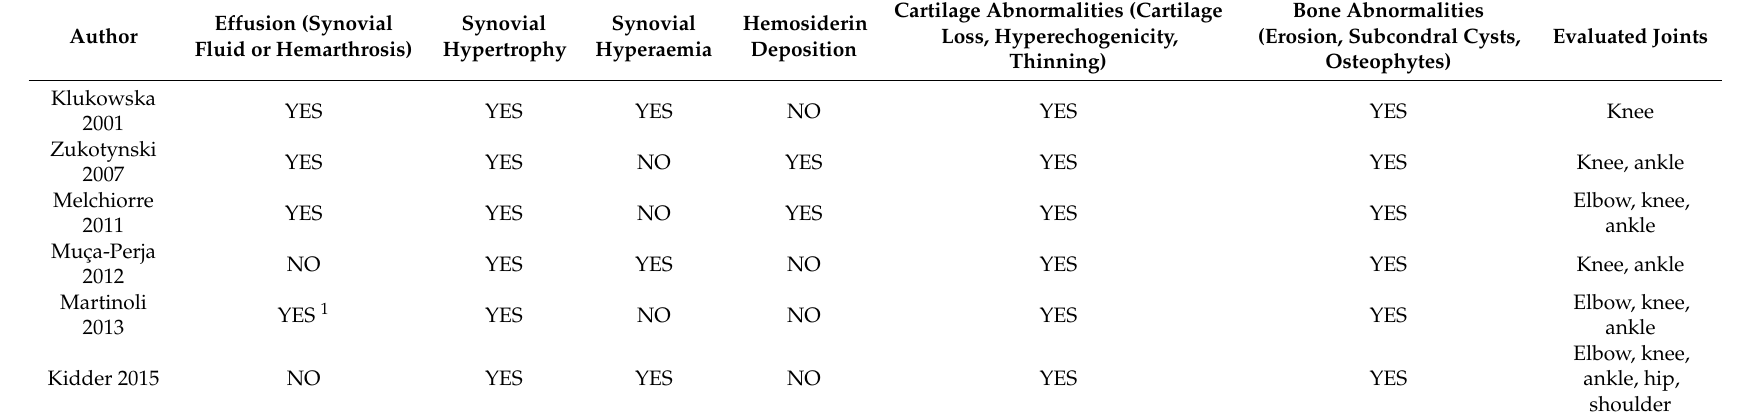
Table 1. Items included in different scanning protocols and scoring systems for ultrasound assessment of hemophilic